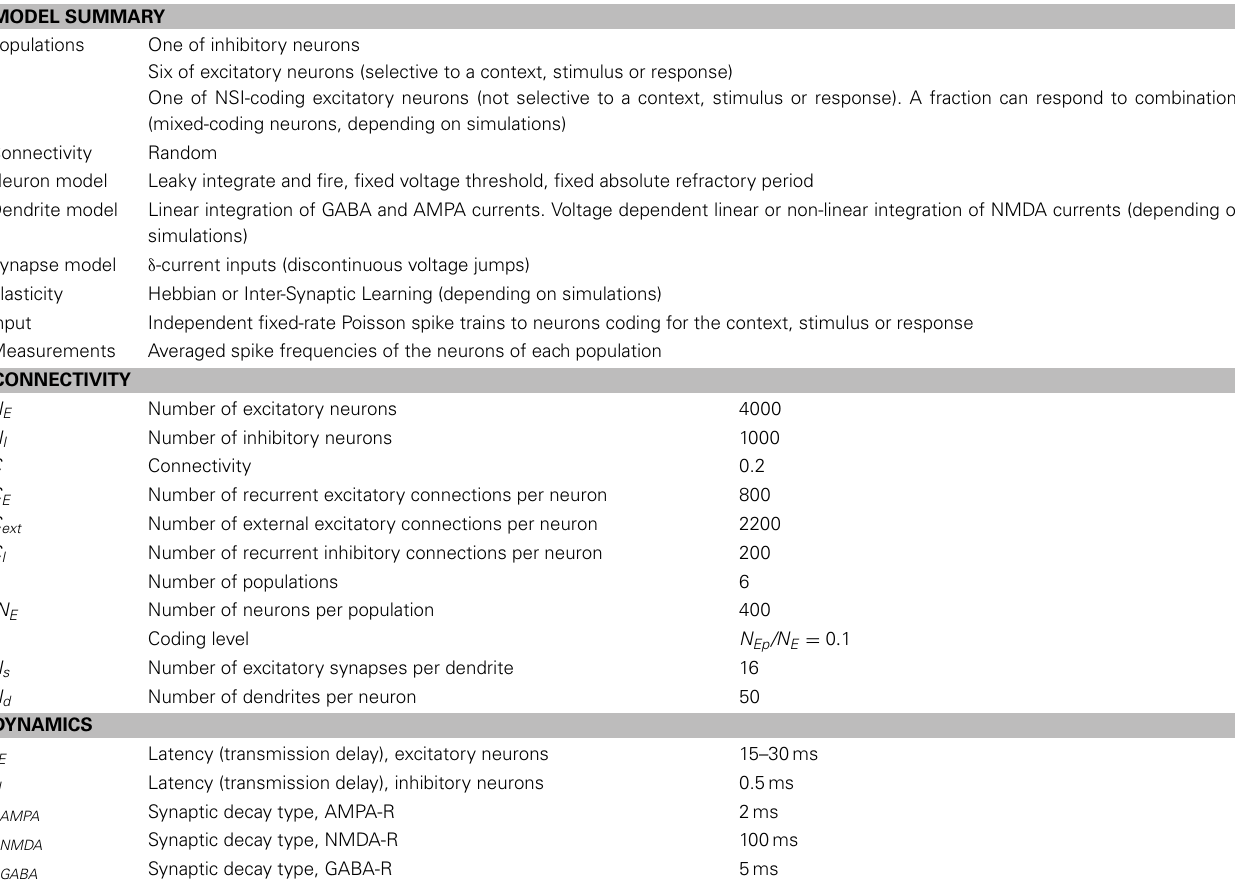
Table 1 | Description and parameters for the model. MODEL